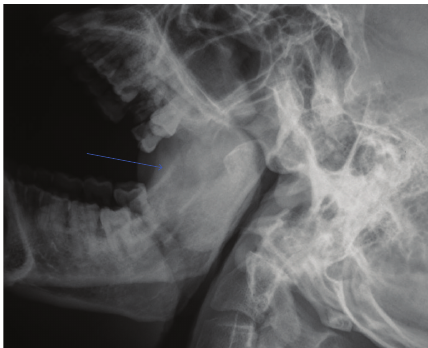
Figure 1: Plain radiograph of soft tissue of nasopharynx lateral view showing well defined round mass (marked by thin arrow) in the oropharyngeal region with no calcification or cavitation and causing significant narrowing of oropharynx.